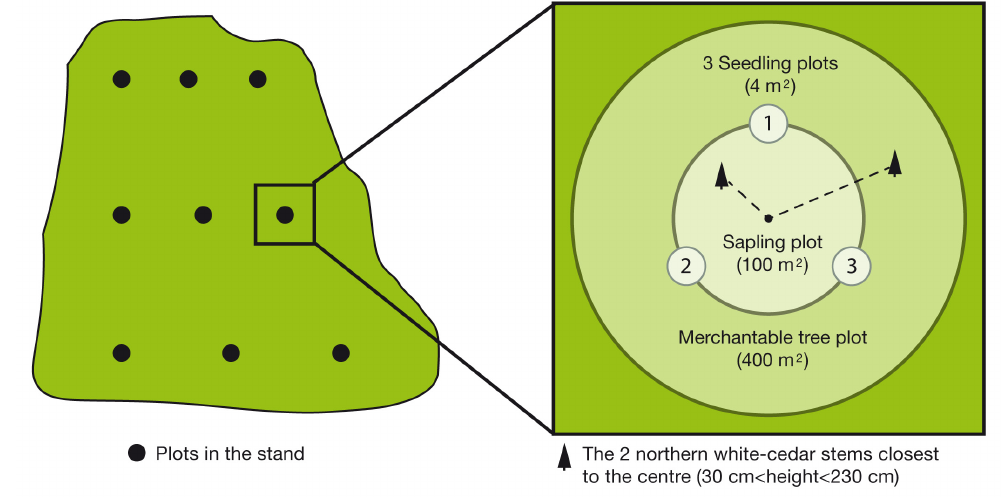
Figure 2. Schematic representation of experimental design used to inventory merchantable trees, saplings, and seedlings on the 3 study sites, and selection of northern white-cedar stems on the Outaouais Region (OR site) and Papineau-Labelle wildlife reserve (PL site). The 2 northern white-cedar stems closest to the center of each sapling plot were selected and numbered on the OR and PL sites ( n = 144 stems). On the OR site, they were 130 to 230 cm tall. On the PL site, very few stems taller than 130 cm were available, so we had to lower the height criterion from 130 to 30 cm. We did not find enough seedlings and small saplings taller than 30 cm on the PEF to conduct stem analyses for this